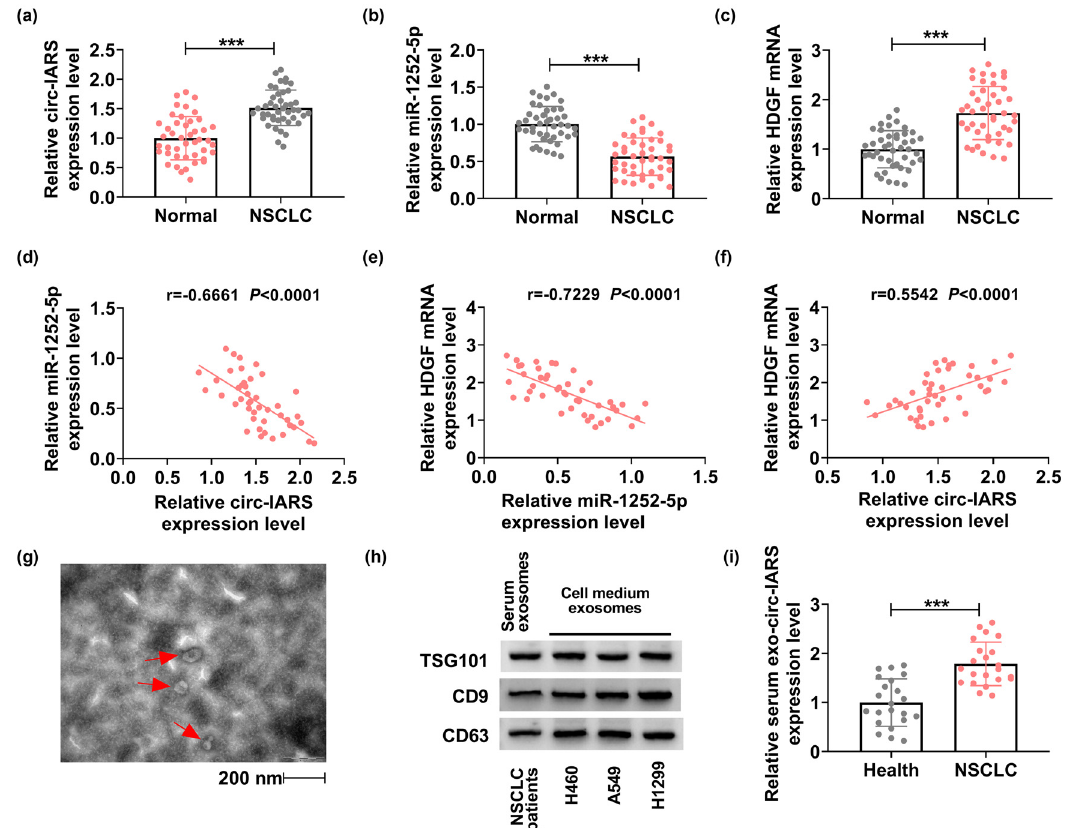
Figure 7: Circ - IARS was upregulated in NSCLC patients. ( a – c ) RT - qPCR detected the relative expression of circ - IARS, miR - 1252 - 5p, and HDGF mRNA in NSCLC tumor tissues ( NSCLC; N = 44 ) , normalized to that in normal para - carcinoma tissues ( Normal; N = 44 ) . ( d – f ) Spearman ’ s rank correlation analysis determined the linear correlation among circ - IARS, miR - 1252 - 5p, and HDGF mRNA expression in NSCLC tumors. ( g ) TEM showed the exosomes isolated from the serum of NSCLC patients. ( h ) Western blotting measured the expression of TSG101, CD9, and CD63 in isolated exosomes from NSCLC serum and NSCLC cell medium. ( i ) RT - qPCR detected the relative exo - circ - IARS expression in the serum of NSCLC patients ( NSCLC; N = 22 ) , normalized to serum from healthy people ( Healthy; N = 22 ) . *** P <